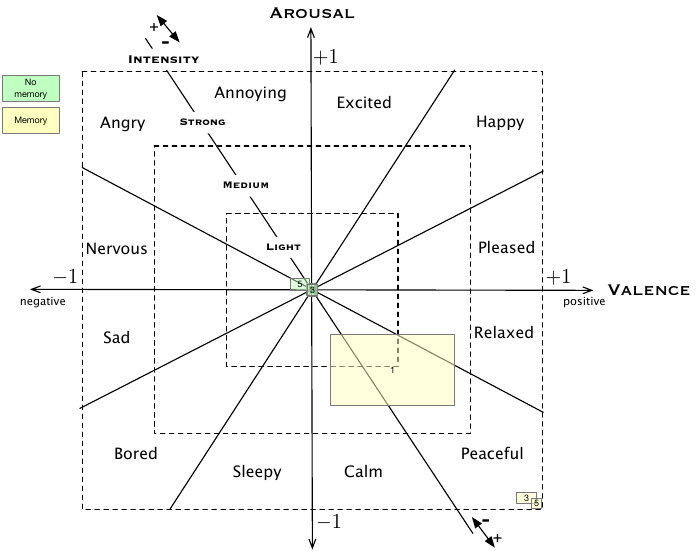
Figure 5. Experiment 2—Hyperbolic